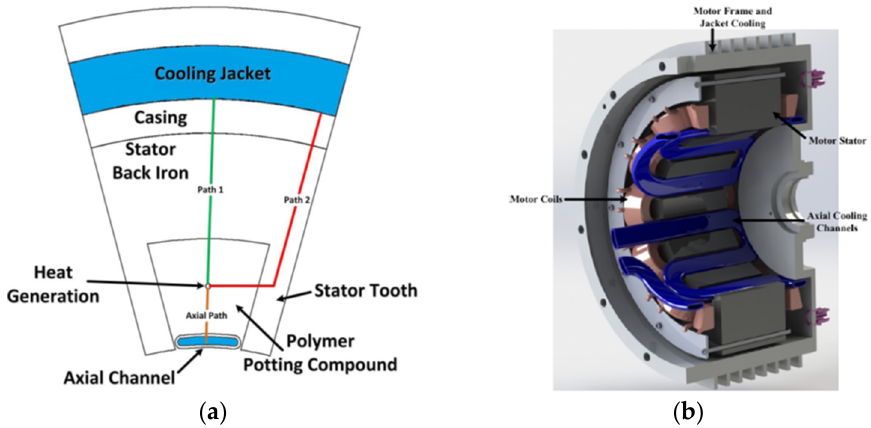
Figure 9. ( a ) Conduction paths and methods for thermal management: the cooling jacket and axial channel and ( b ) a schematic view of e ‐ machine cross ‐ section with conduction paths [24].